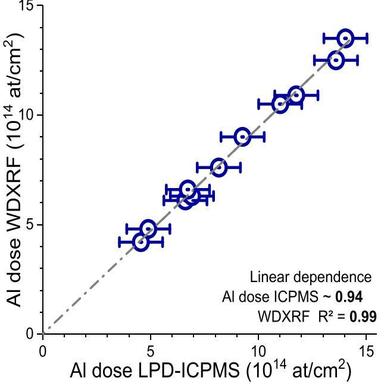
Al Dose in ultrathin Al2O3 as determined by LPD-ICPMS and WDXRF. The experimental data (blue rings) demonstrate a linear dependence (gray dashed line). (For interpretation of the references to colour in this figure legend, the reader is referred to the web version of this article.)